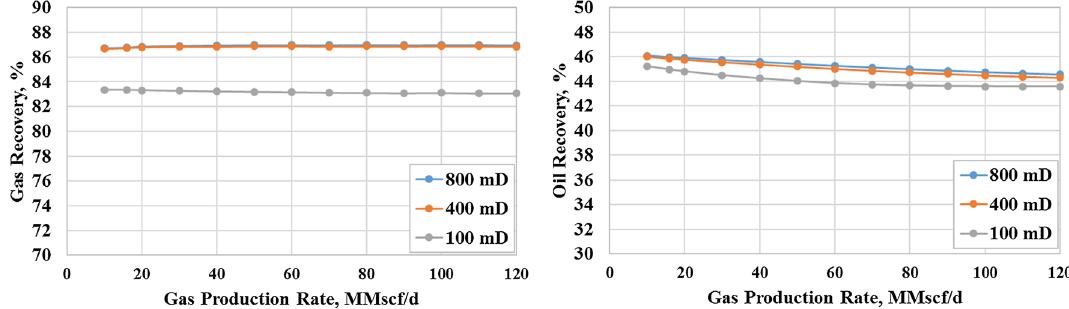
Fig. 30 Gas and oil recoveries for different horizontal permeabilities at various production rates